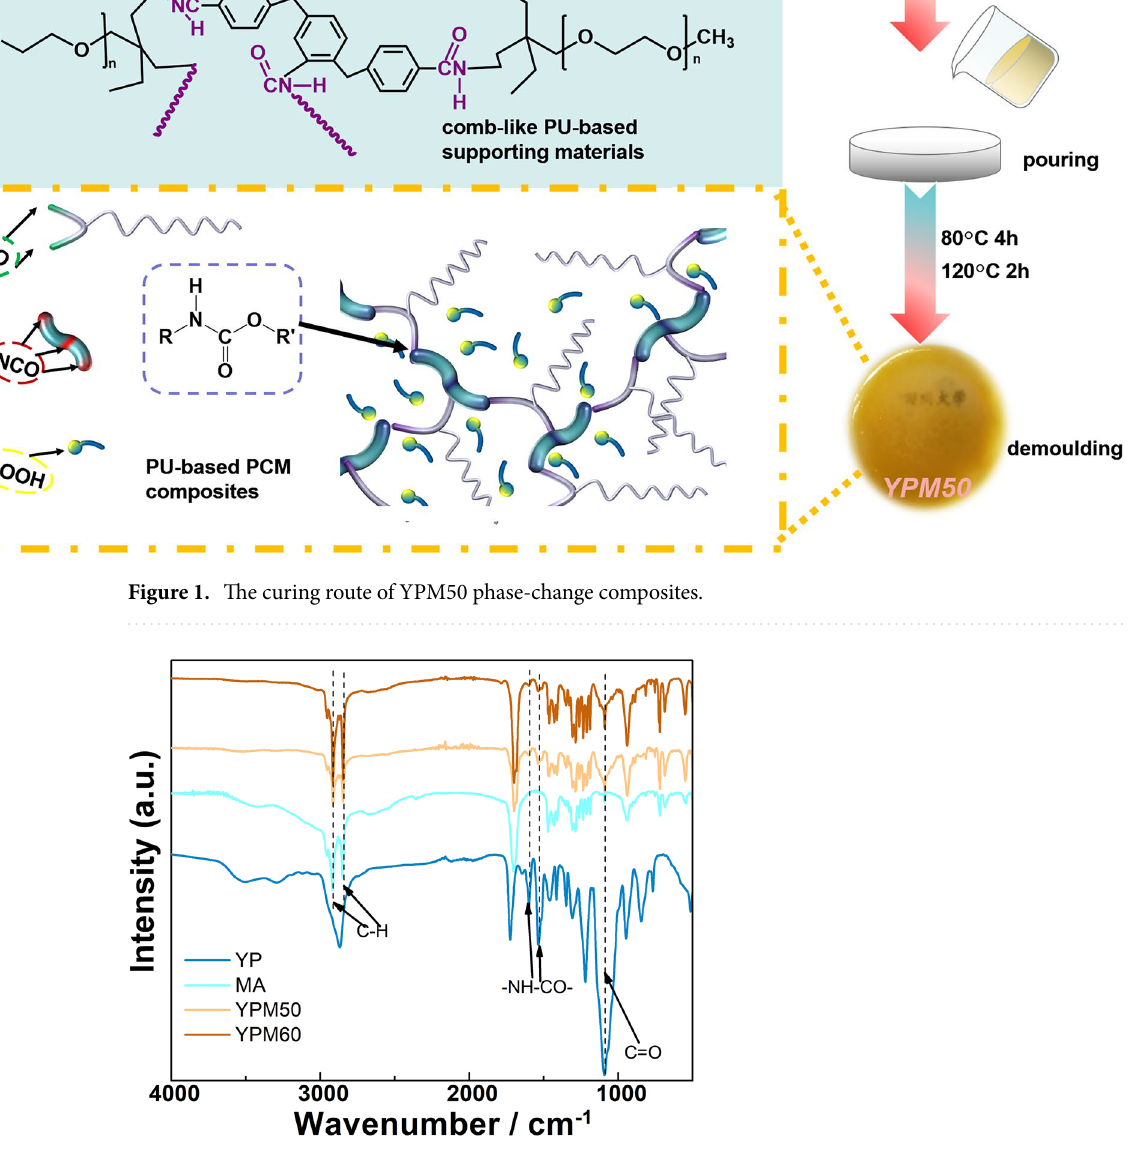
Figure 2. The FTIR spectra of YP, MA, YPM50 and